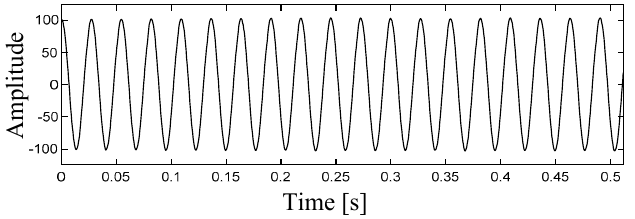
Figure 15. The time domain waveform of the displacement signal.